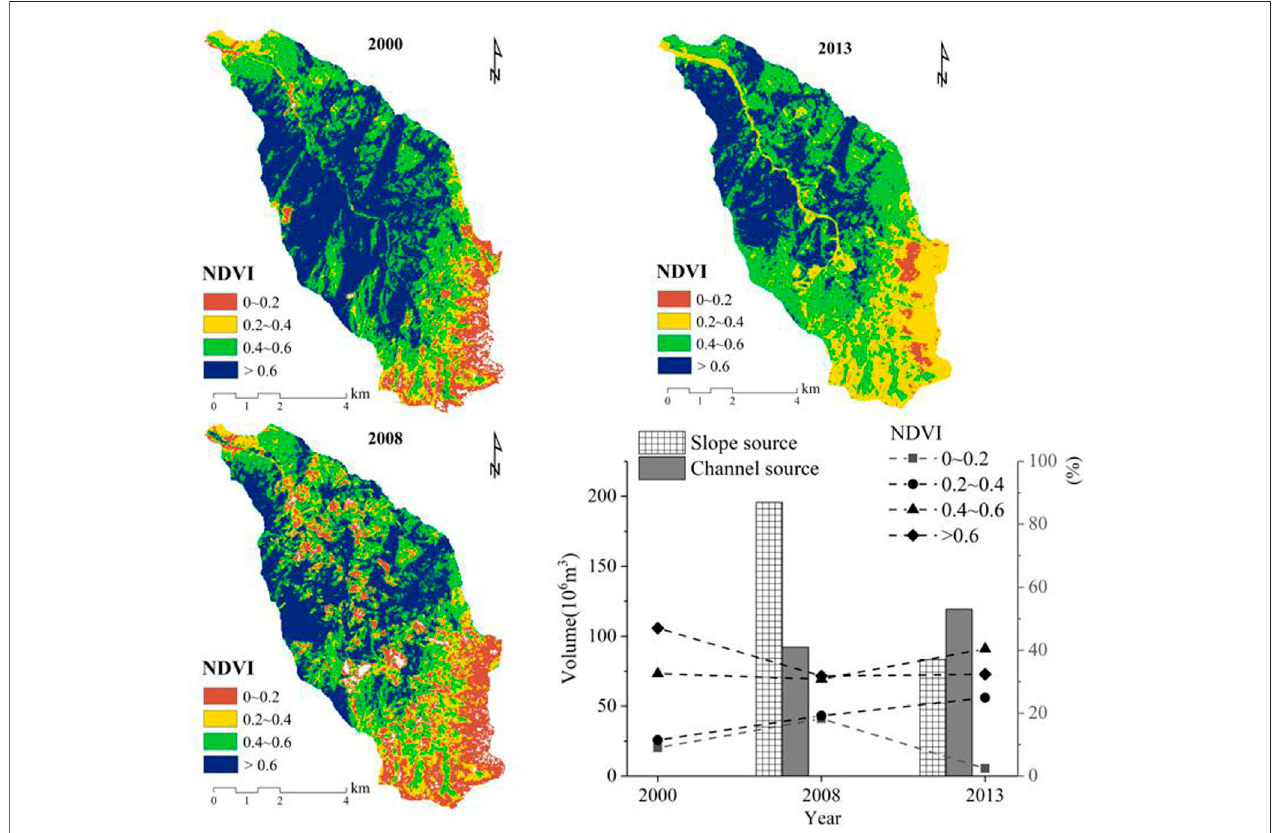
FIGURE6| Spatio-temporaldistributionofthenormalizeddifferencevegetationindex(NDVI)in2000,2008,and2013.Greenrepresentsareaswithhighvegetative cover, and red represents areas with low or no vegetative cover.